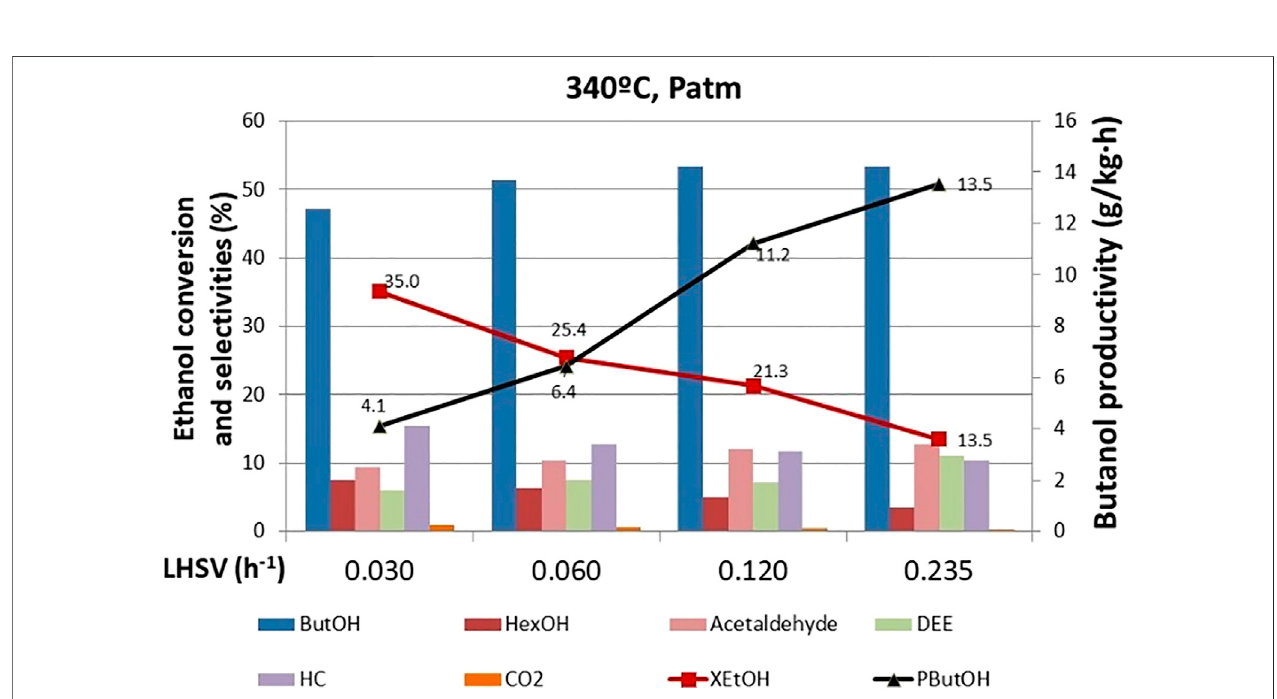
FIGURE 7 | Effect of LHSV on ethanol conversion, butanol productivity, and selectivity to products. ButOH = butanol; HexOH = hexanol; HC = hydrocarbons; DEE = diethyl ether.